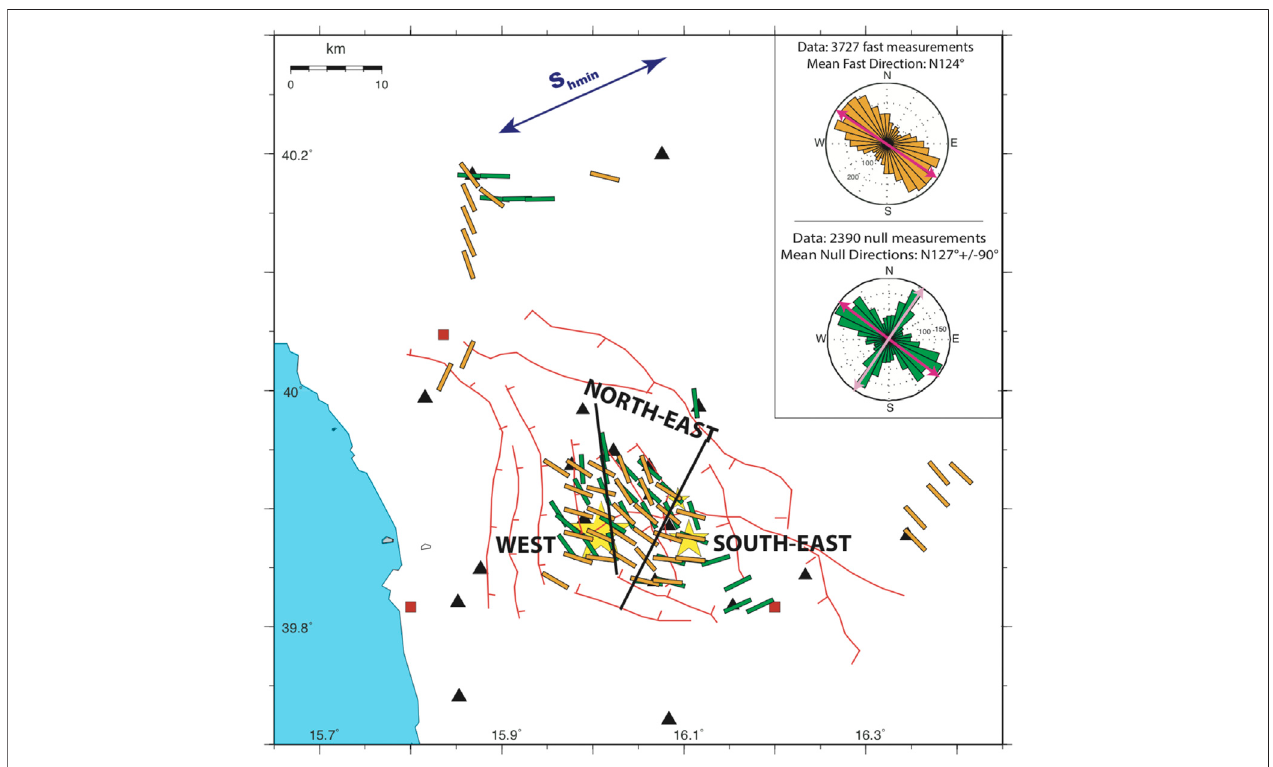
FIGURE 9 | Map of the spatial average for 3,727 fast (orange bars) and 2040 null (green bars) measurements. Three sectors are recognized: West) even if a WNW – ESE mean direction is observed, fast and null orientations are variables and not coincident; North-East) a NNW – SSE mean direction is visible, fast and null orientations are stables and coherent; South-East) a trend from NW – SE to E – W mean direction is delineated from both fast and nulls measurements. The upper right insets show the total rose diagrams for both fast and null measurements.